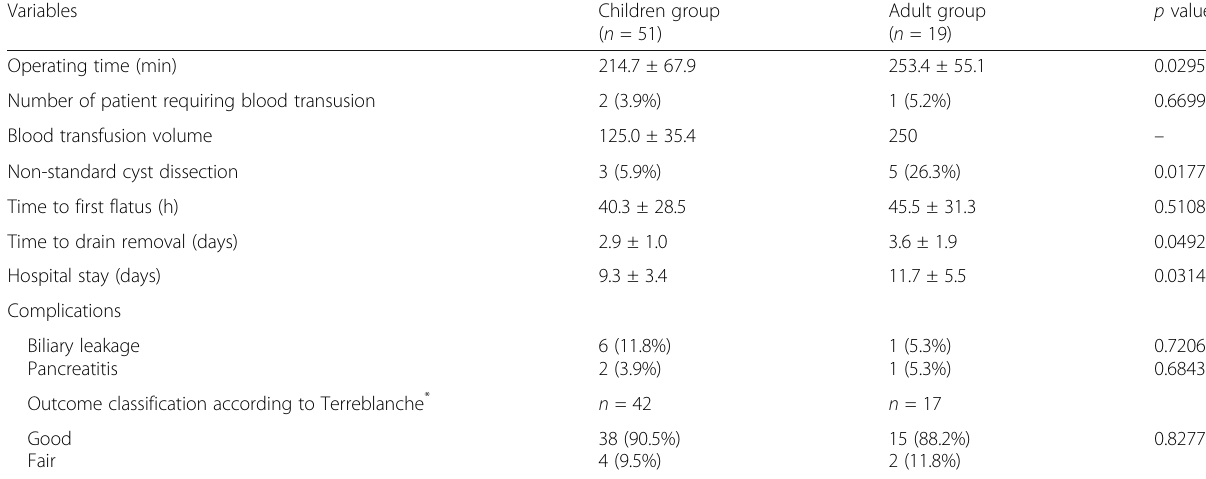
Table 2 Surgic а l о utc о mes о f l а p а r о sc о pic ch о led о ch а l cyst excisi о n а nd R о ux-en-Y hep а tic о jejun о st о